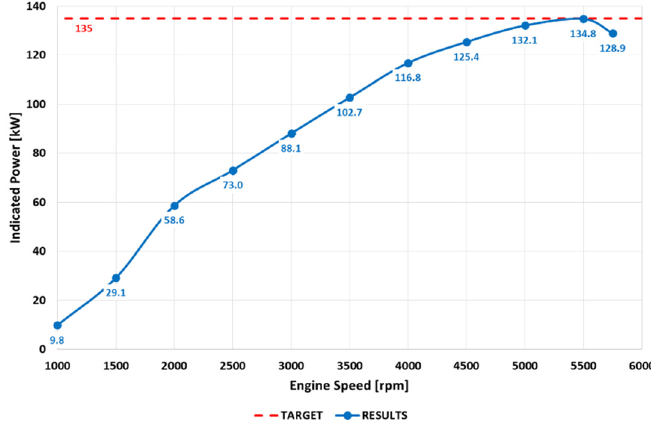
Figure 9. The predicted engine indicated power.